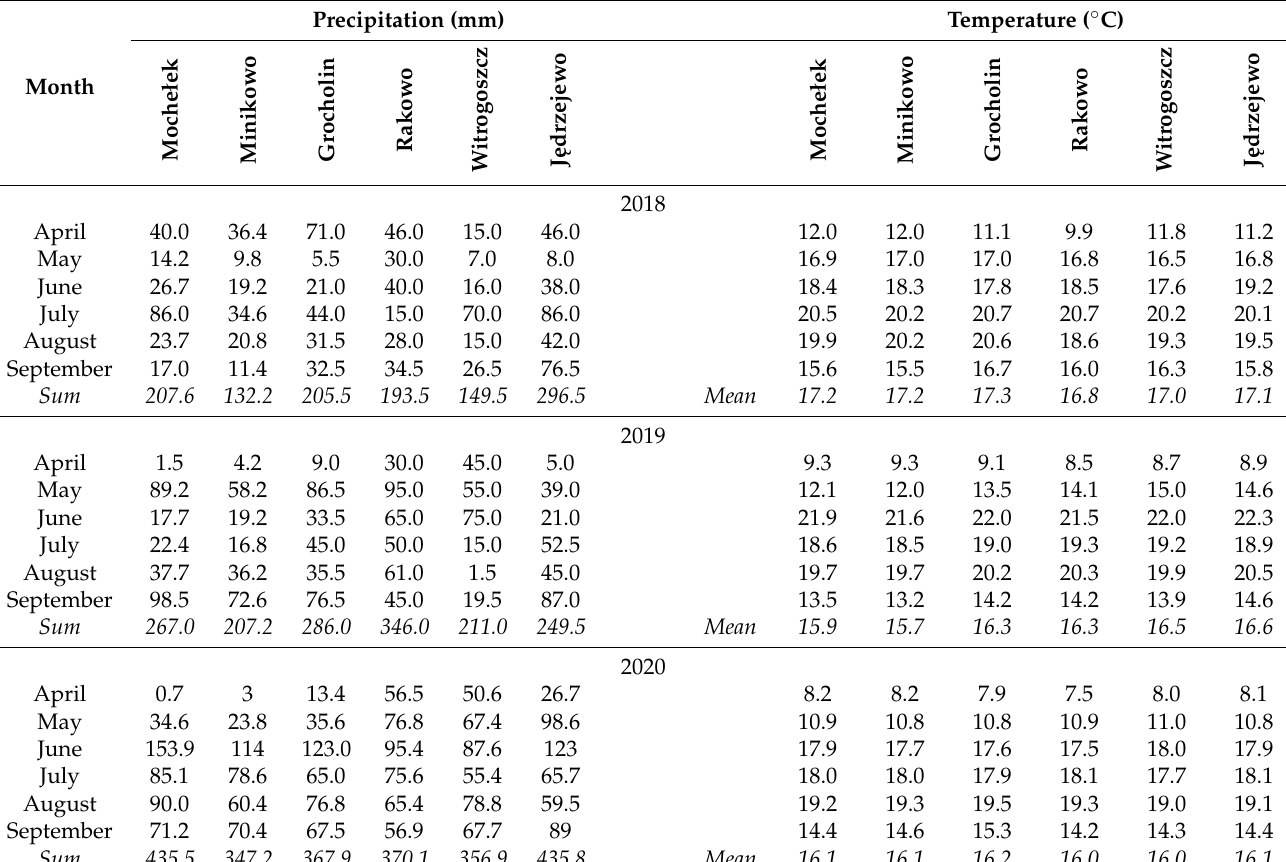
Table 4. Monthly sum of precipitation and monthly mean temperatures during seasons at the sites of the study.